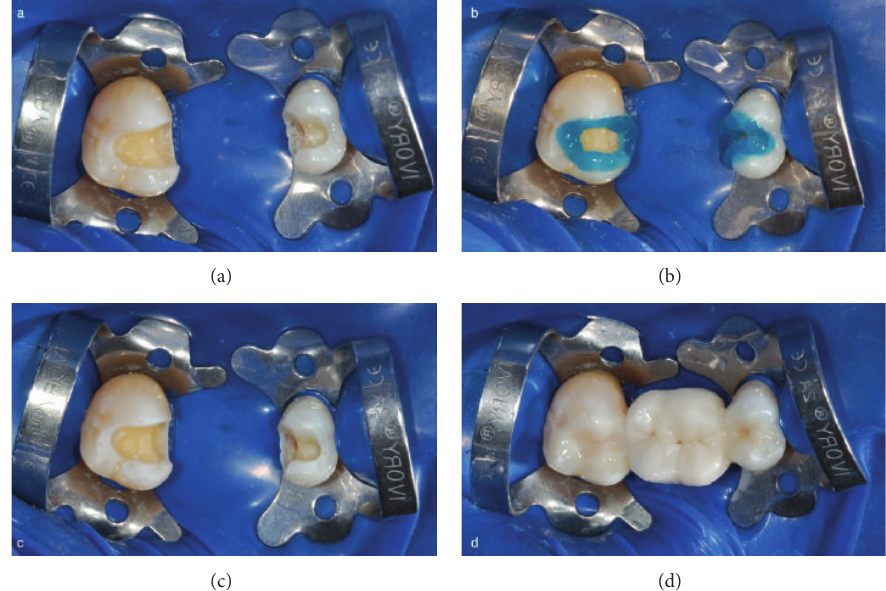
Figure 9: (a) Operative field isolation with dental dam. (b) Selective phosphoric acid etching. (c) Etched enamel and dentin surfaces. (d) A resin composite dual-curing cement was used.